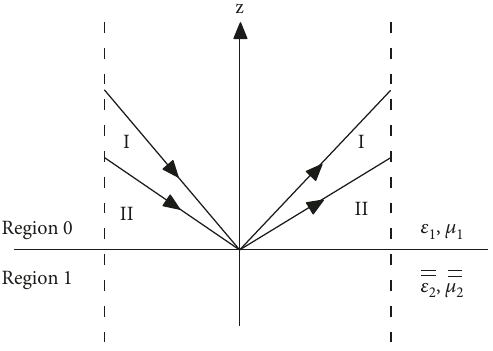
Figure 4: The re fl ection of the anisotropic